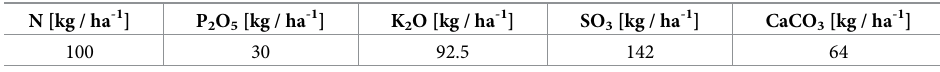
Table 2. Sum of nutrients used in the experiment in all assessed treatment